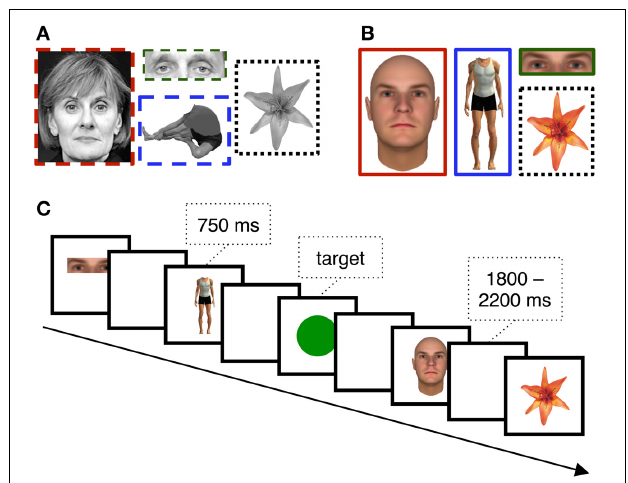
FIGURE 1 | EEG Stimuli and Task. Example (A) grayscale and (B) color stimuli used for different subsets of the patients. The task (C) was simple target detection task in which patients reported the presence of the circle targets with a